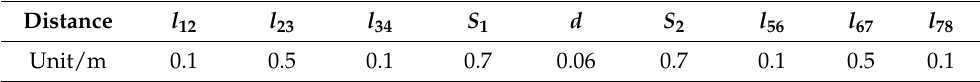
Table 1. The distance between hydrophones and the distance from hydrophones to the surface of